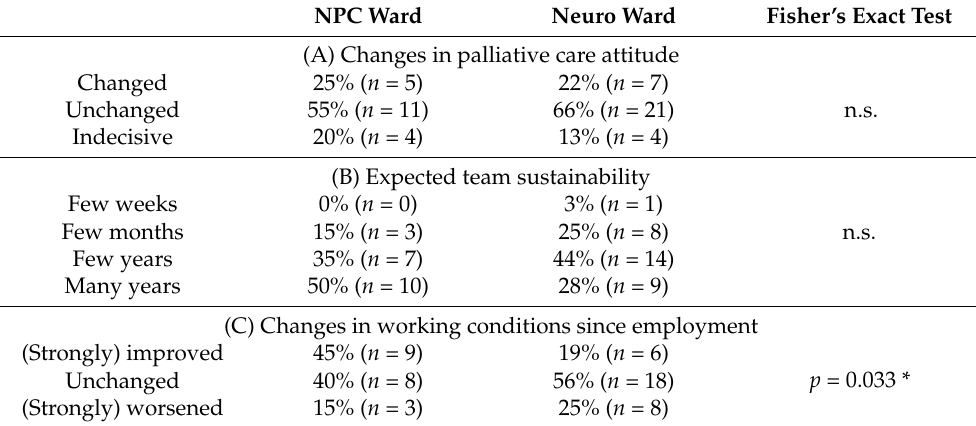
Table 4. Changes in palliative care attitude ( A ), expected team sustainability ( B ), and changes in working conditions ( C ) on the NPC ward and neuro ward with relative and absolute numbers. The changes in working conditions were combined to “(strongly) improved” and “(strongly) worsened”. * Statistically significant differences ( p <